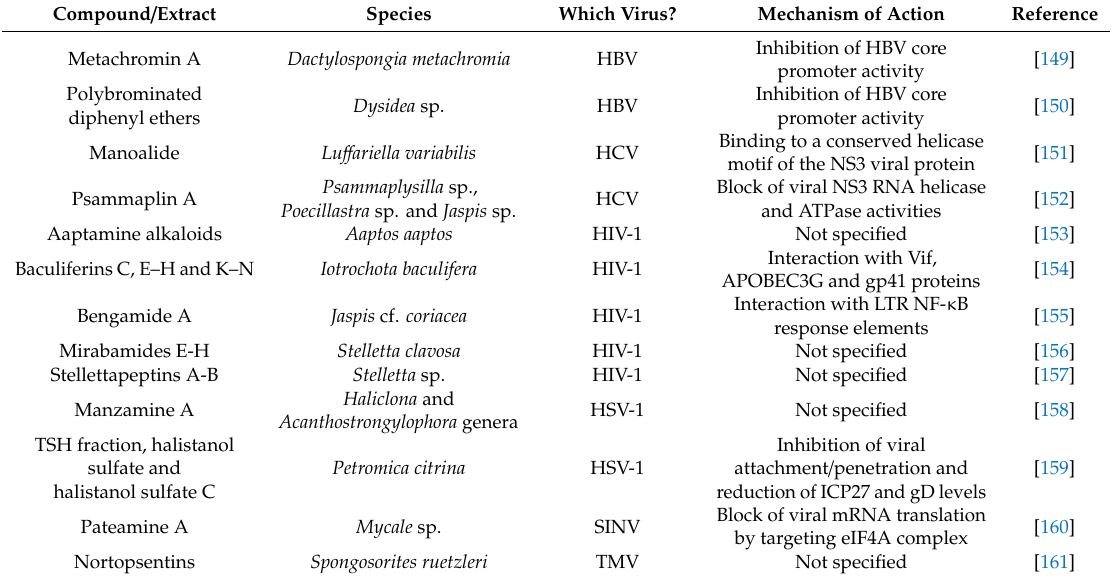
Table 6. The table report antiviral compounds / extracts from marine sponges. HBV, Hepatitis B virus; HCV, Hepatitis C virus; HIV-1, Human Immunodeficiency virus type 1; HSV-1, Herpes Simplex virus 1; SINV, Sindbis virus; TMV, Tobacco Mosaic virus.